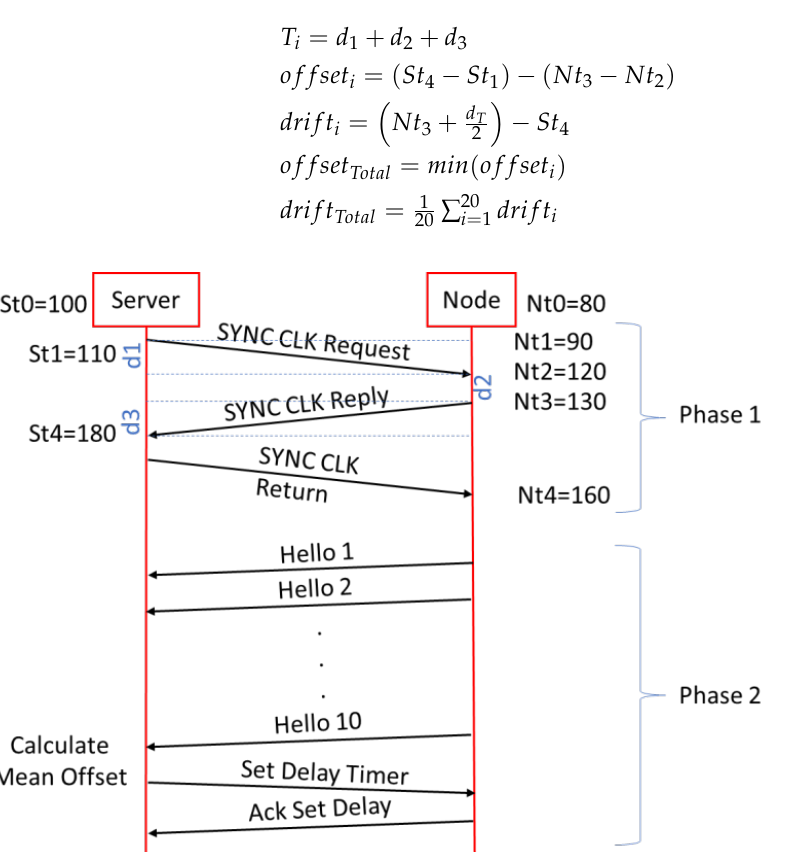
Figure 6. Sequence of synchronization between the RPI server and one node.